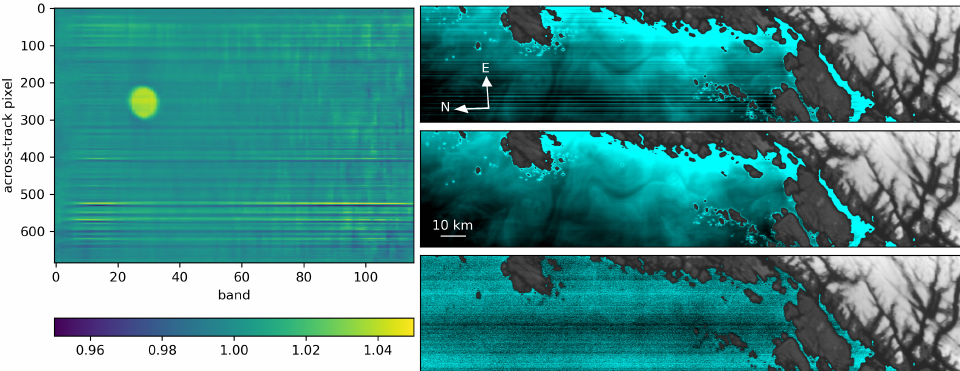
Figure 13. The multiplicative correction applied to the radiometric calibration in order to destripe acquired hyperspectral images ( left ). The first PCA component of the ocean pixels from the test scene without destriping ( right , top ), the first component computed after the image has been destriped ( middle ), and the seventh component in the destriped image ( bottom ). The image shows Frohavet, outside of Trondheim,